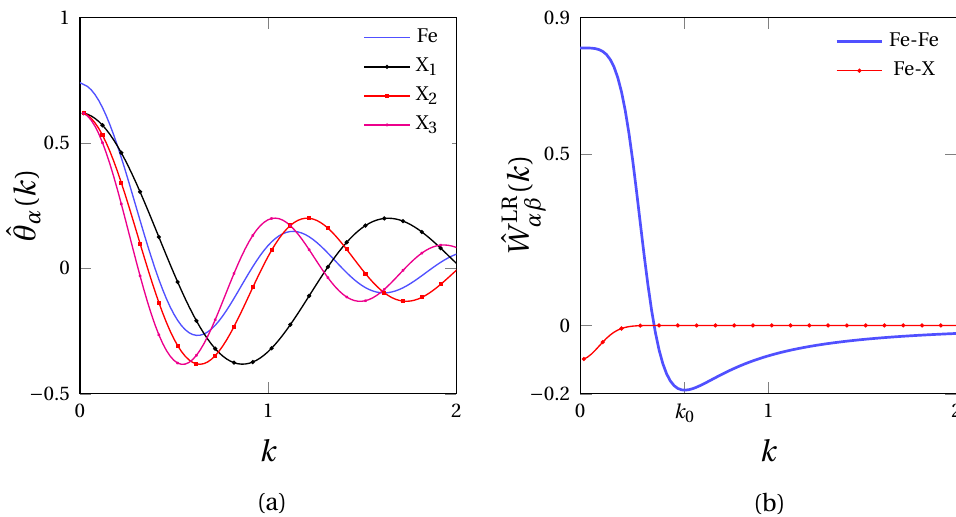
(blue) and ˆ W LR Fe Fe-X